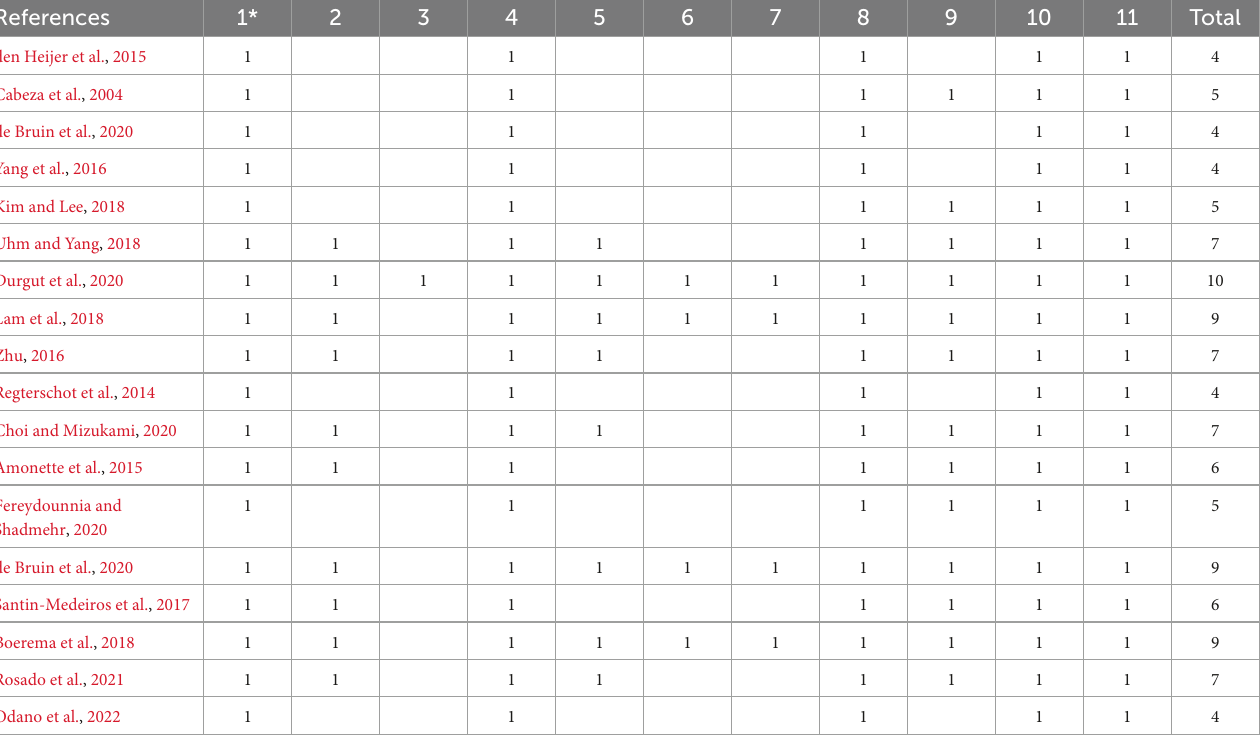
TABLE 2 Study quality using the PEDro scale.